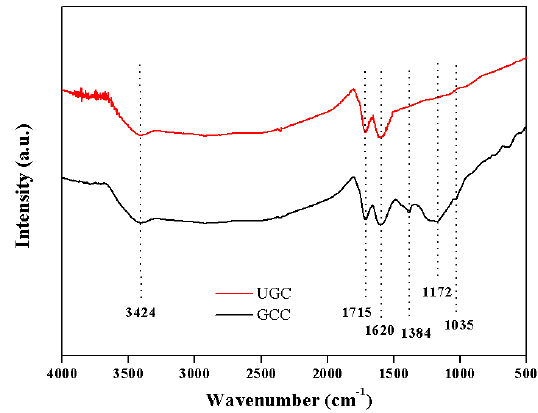
Figure 2. FT-IR spectra of UGC and GCC.